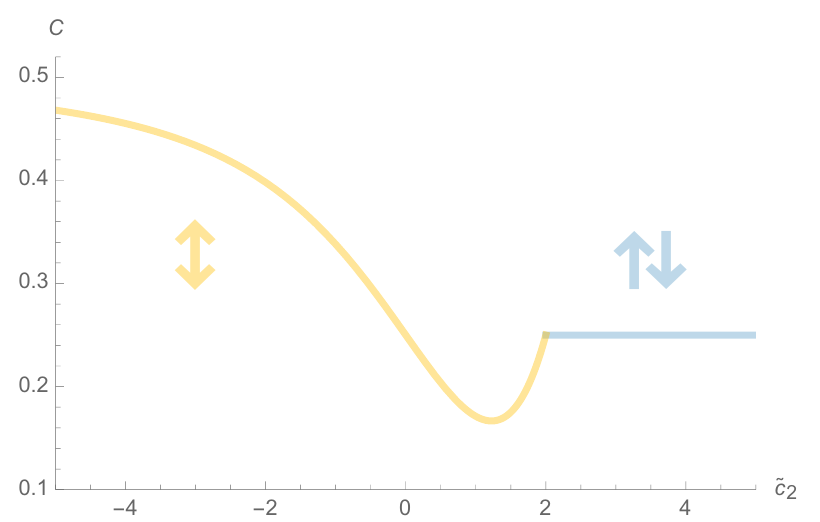
Figure 2 . 3rd order l→↑↓ transition in the PP model for Derivative of the specific heat has a discontinuity at